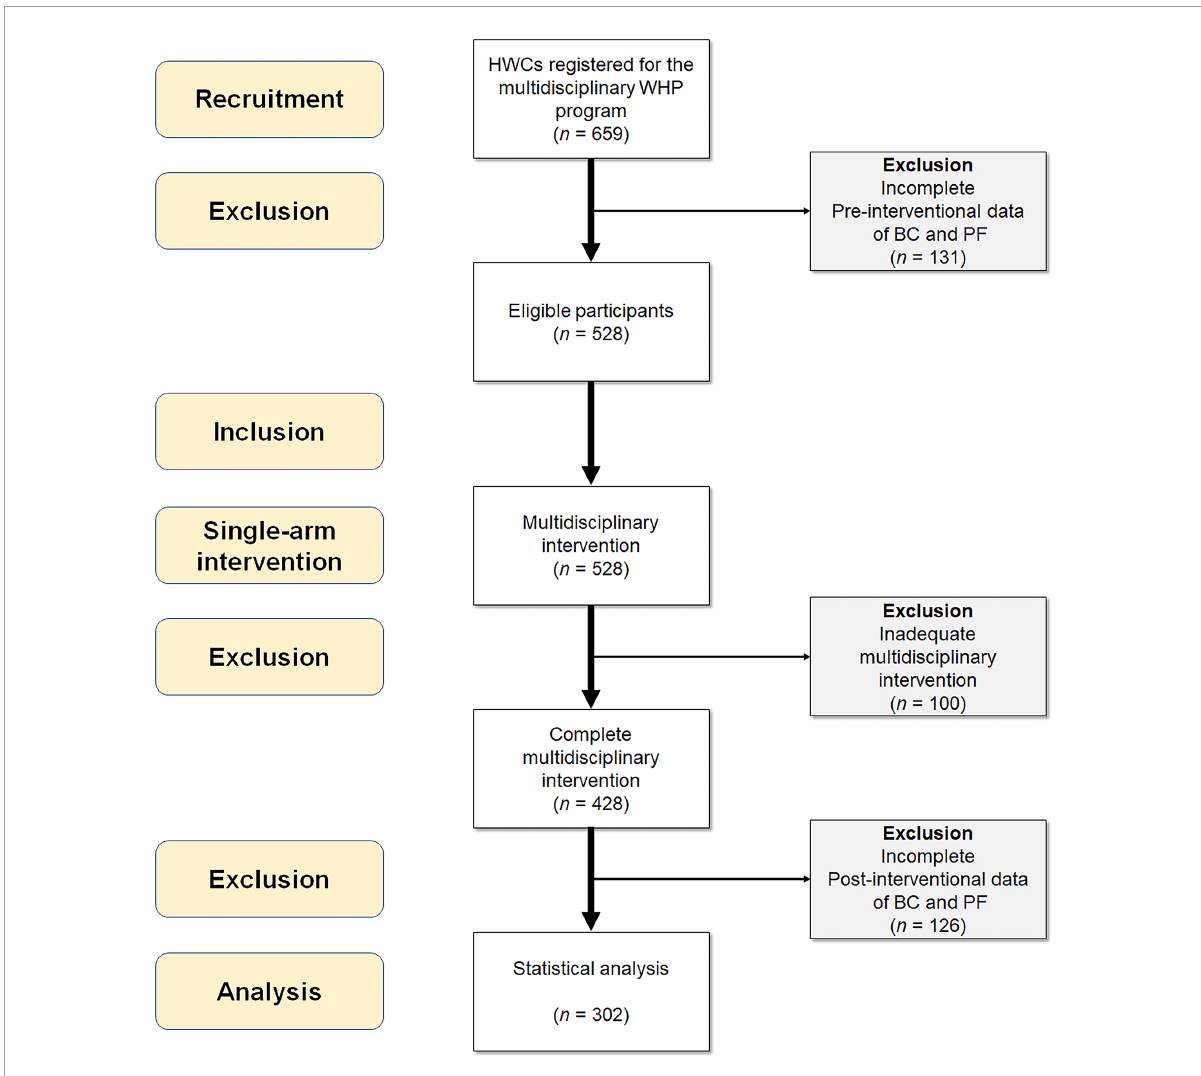
FIGURE2 Inclusion flow chart of the study participants. BC, body composition; PF, physical fitness; WHP, workplace health